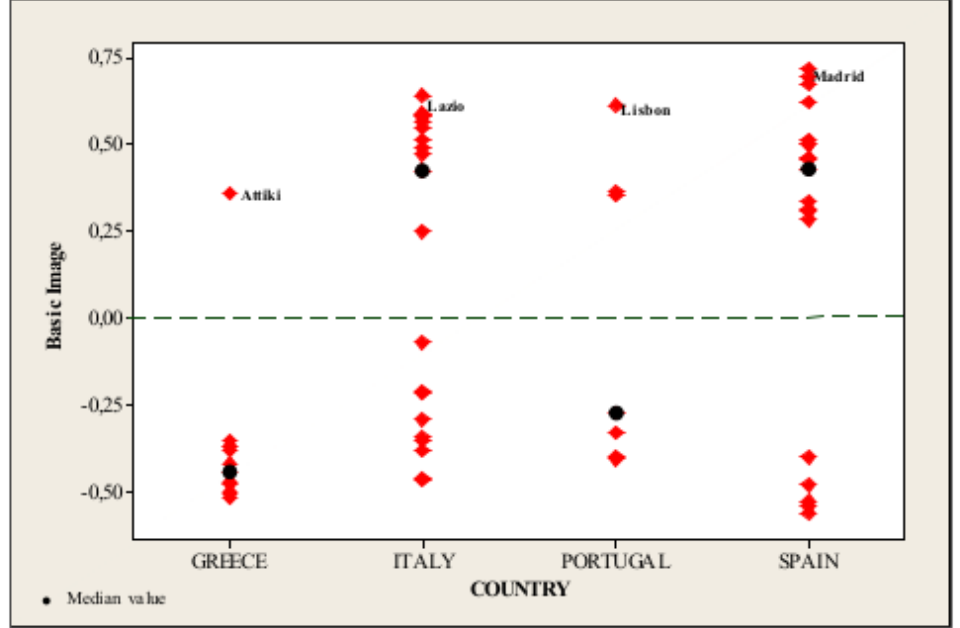
Figure 2: The Basic Image of the 60 south European